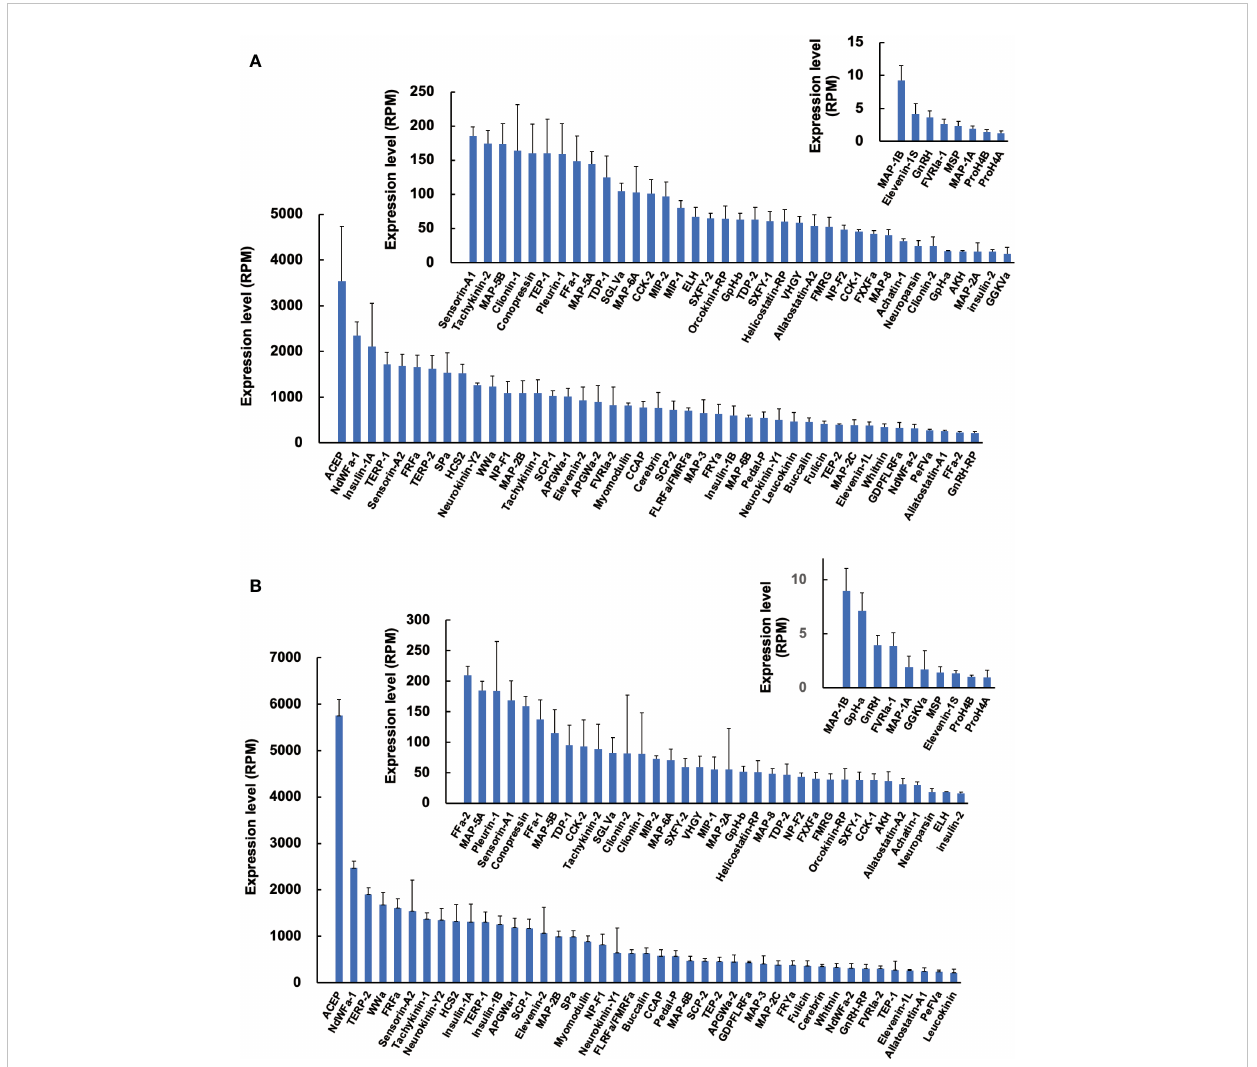
FIGURE 2 Expression levels of neuropeptide precursors in CNS of normal snail. Expression levels of neuropeptide precursors in female (A) and male (B) were expressed in RPM determined by RNA-seq analysis. Each column and vertical bar represent mean ± S.E., respectively (N = 4 for female, N = 3 for male). For the abbreviated names of neuropeptides, refer to Table